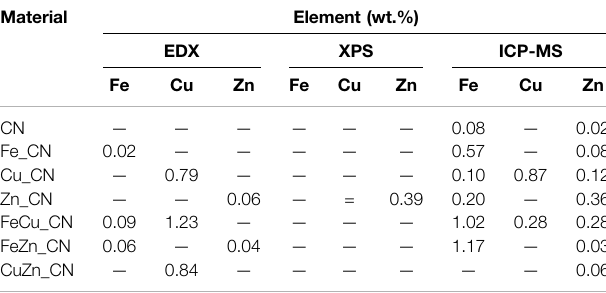
TABLE 1 | Comparative elemental composition of CN-based materials by SEM- EDX, XPS and ICP-MS analyses. Material Element